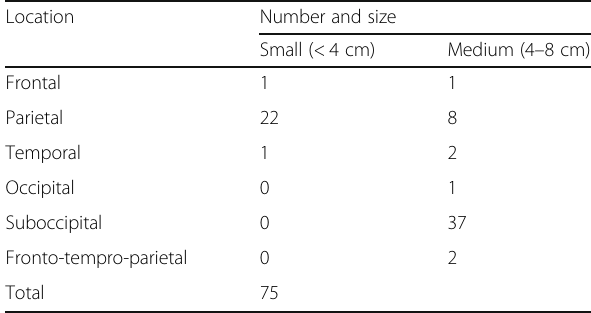
Table 3 Size of reconstructive